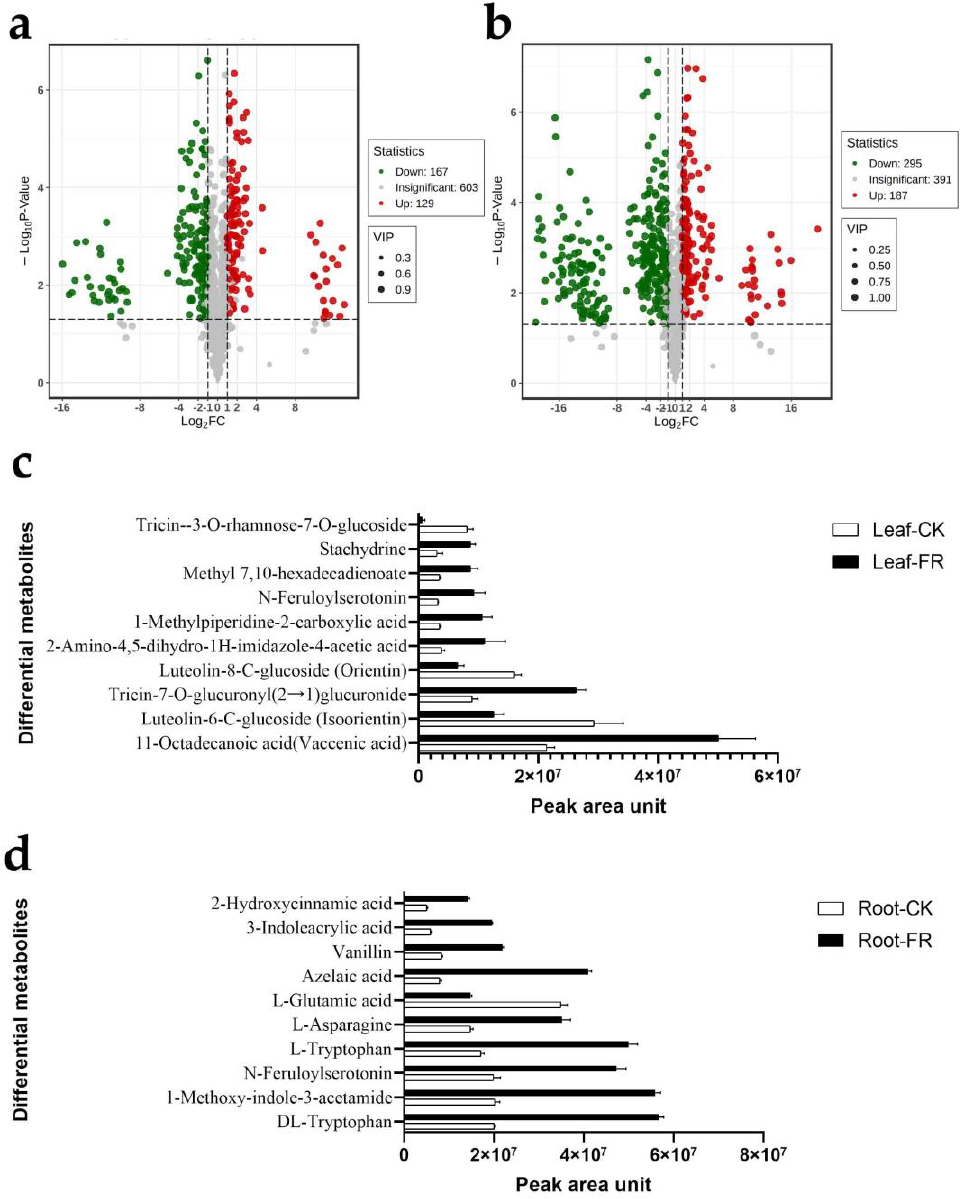
Figure 6. Differential metabolites in LC of FR and CK zones of LM fairy rings. Volcano map of differential metabolites identified from the ( a ) leaves and ( b ) roots of LC in FR and CK zones. Each point in the volcano plot represents a metabolite; green represents the downregulated metabolites, red represents the upregulated metabolites, and gray represents the detected metabolites with no significant difference. The horizontal coordinate represents the log value of the metabolite difference between the FR and CK groups (log 2 FC); the ordinate represents the significance level ( − log 10 P- value); the dot size represents the VIP value. Top ten most abundant differential metabolites in ( c ) leaves and ( d ) roots of LC in FR and CK zones. The abscissa represents peak area units, and the ordinate represents the differential